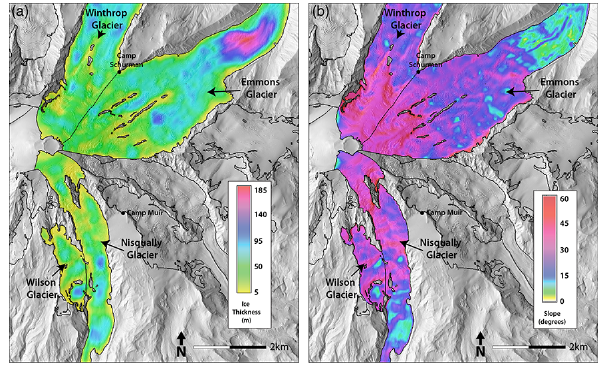
Figure A5. (a) Filtered ice thickness and (b) filtered slope used as model